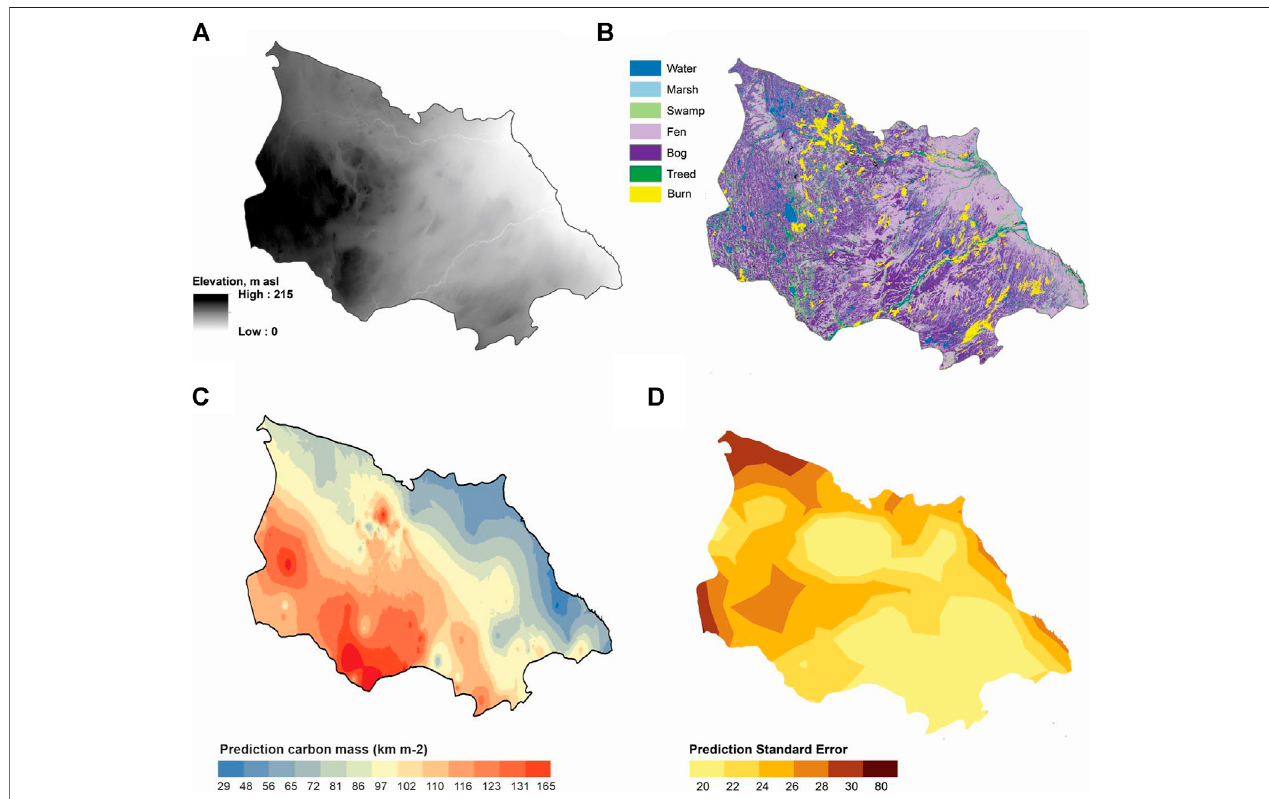
FIGURE4| Selected characteristics inthe 74,300 km 2 studyarea inthe southern Hudson BayLowlands: (A) elevation, (B) land cover, (C) peatcarbon mass, and (D) uncertainty of peat carbon mass; expressed as standard error of carbon mass measurements.